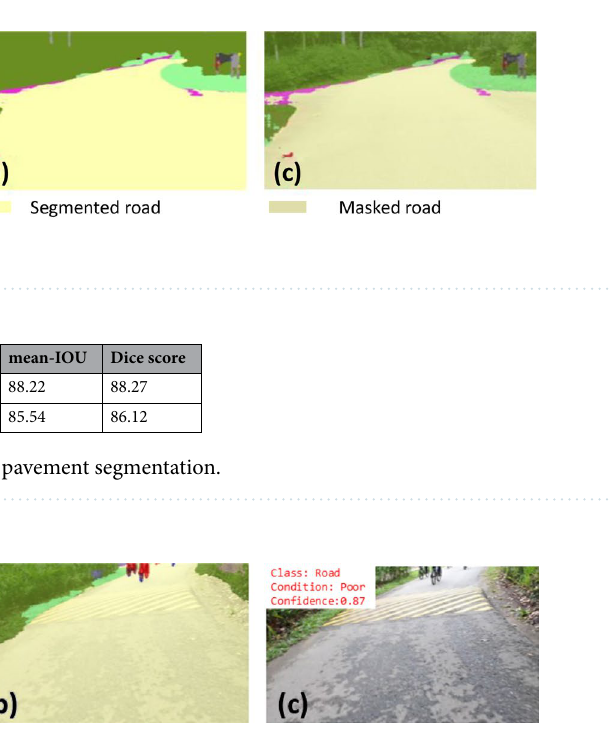
Figure 26. Pavement condition: bad.